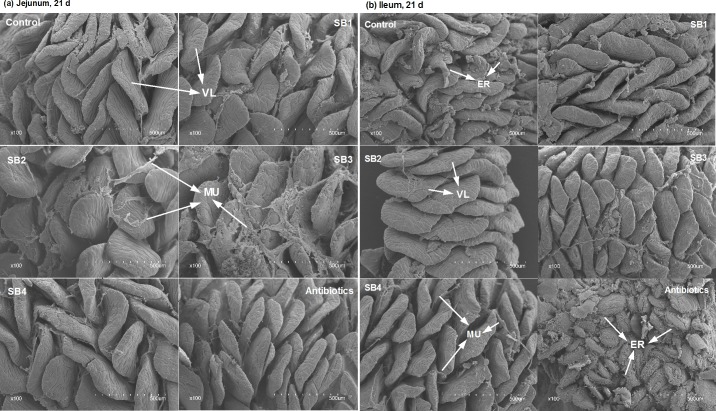
The surface morphology and distribution of villi.Jejunum (a) and ileum (b) specimens were collected at 21 d and then analyzed by scanning electron microscopy at 200× for changes in the appearance and structure of villi (VL) as well as the presence of mucus (MU) or erosion (ER, white arrow).